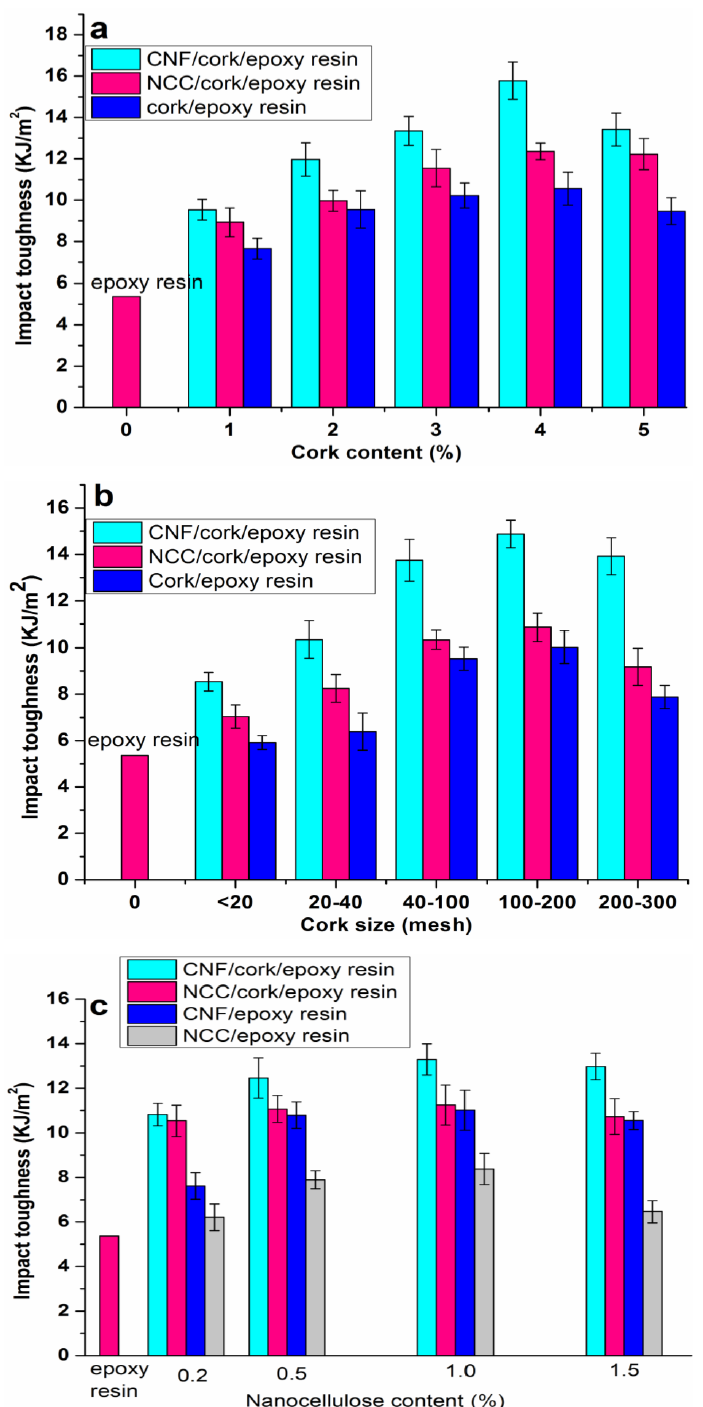
Figure 5. The impact toughness of the rosin-based composites: ( a ) composites with different cork contents, ( b ) composites with different cork sizes, ( c ) composites with different nanocellulose contents.